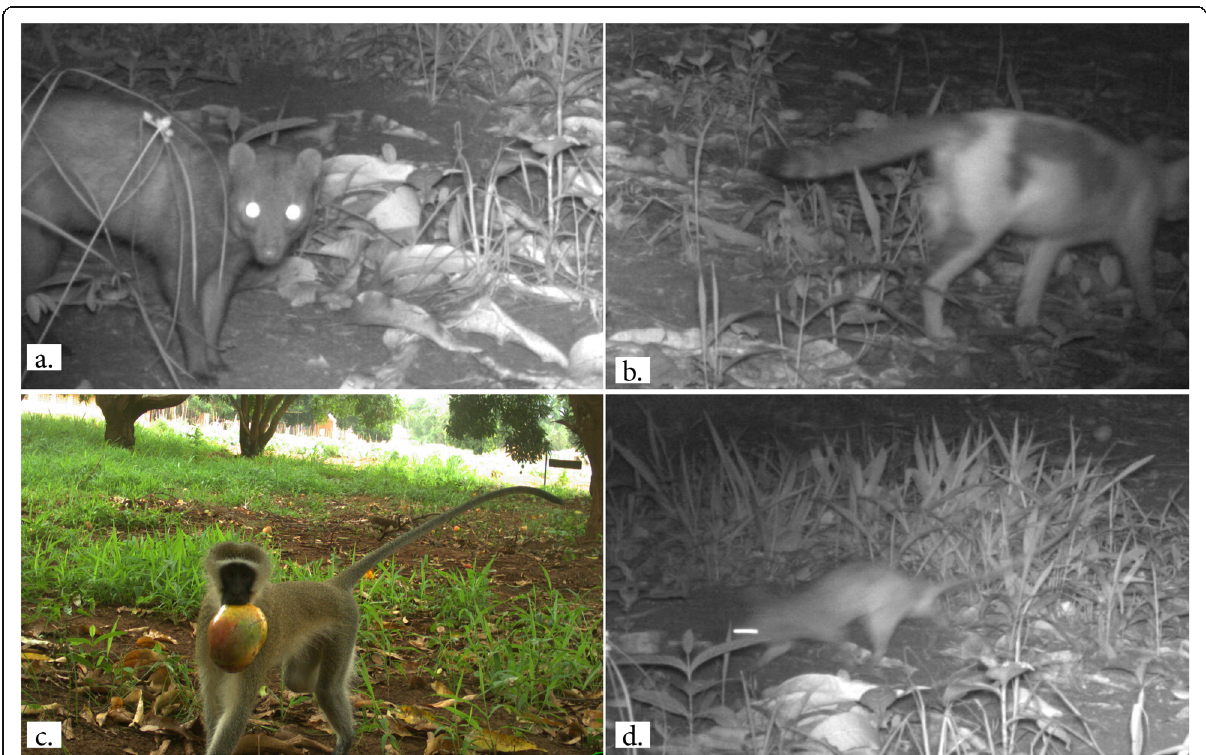
Fig. 7 Pictures of species detected at the camera-trap site. a Common dwarf mongoose ( Helogale parvula ). b Domestic cat ( Felis catus ). c Vervet monkey ( Chlorocebus pygerythrus ). d Black rat ( Rattus rattus